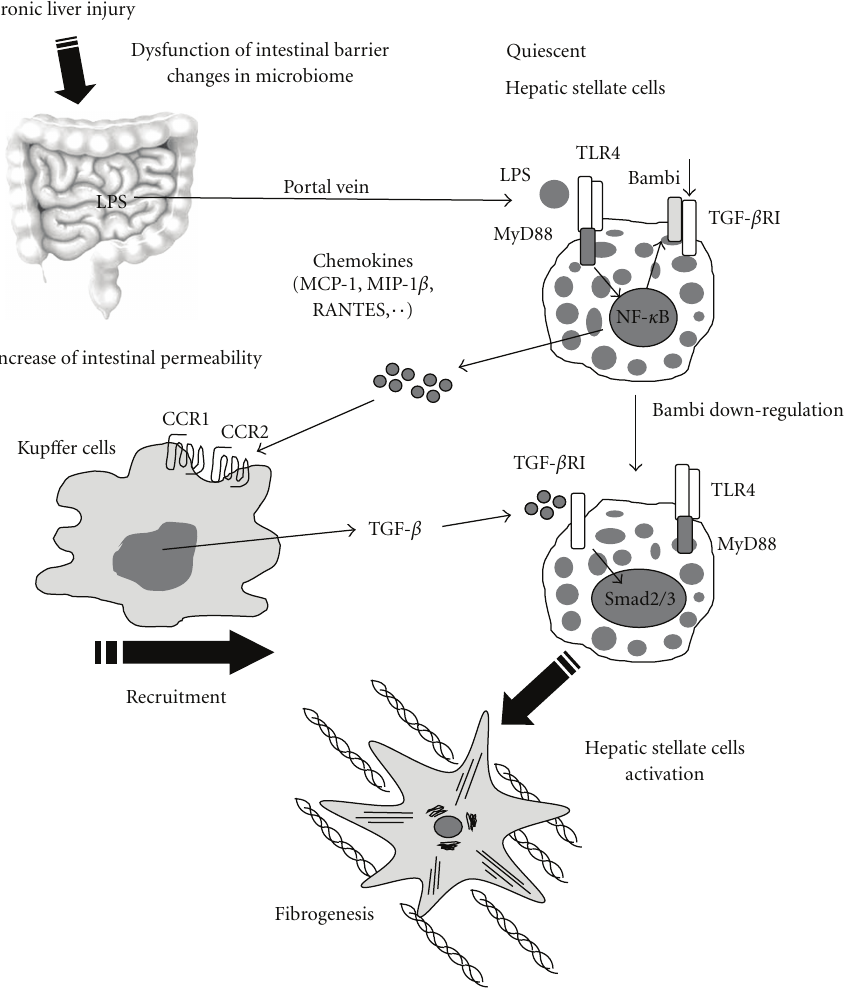
Figure 1: TLR4 signaling enhances TGF- β signaling in hepatic stellate cells. Upon liver injury, intestinal permeability is increased due to the intestinal dysbiosis and tight junction disintegrity, which allows microflora-derived LPS into the portal vein. This LPS stimulates TLR4 on hepatic stellate cells (HSCs). Quiescent HSCs express high levels of Bambi which restricts TGF- β signaling. TLR4 stimulation leads to the production of various chemokines (MCP-1, MIP-1 β , and RANTES) in HSCs, recruiting Kup ff er cells through their CCR1 and CCR2. Recruited Kup ff er cells produce TGF- β which binds to TGF- β receptor type I in HSCs. Simultaneously, TLR4 signaling downregulates Bambi expression through MyD88 and NF- κ B in HSCs. HSCs become free from restricted TGF- β signaling by the downregulation of Bambi, which eventually induces HSC